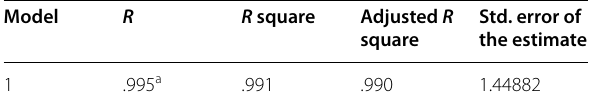
Table 9 Regression model for time of death